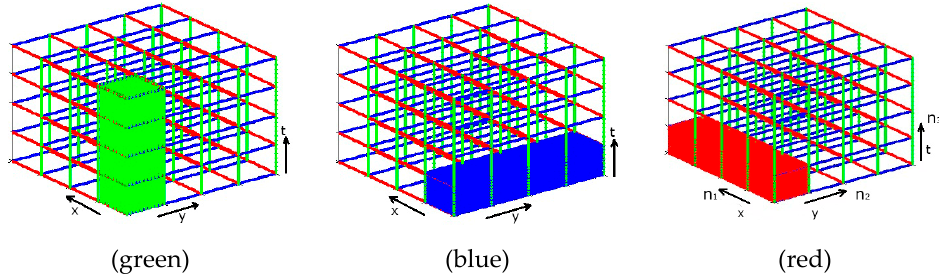
Figure 9. A 3D image cube of 4 × 4 × 4 pixels. Since the 3D FFT is a separable procedure, it can be performed in 3 phases (green, blue, red). In each phase, the result from the previous phase is used as input. The obtained result of the 3D FFT procedure is irrelevant of the order that the 3 above phases are applied.